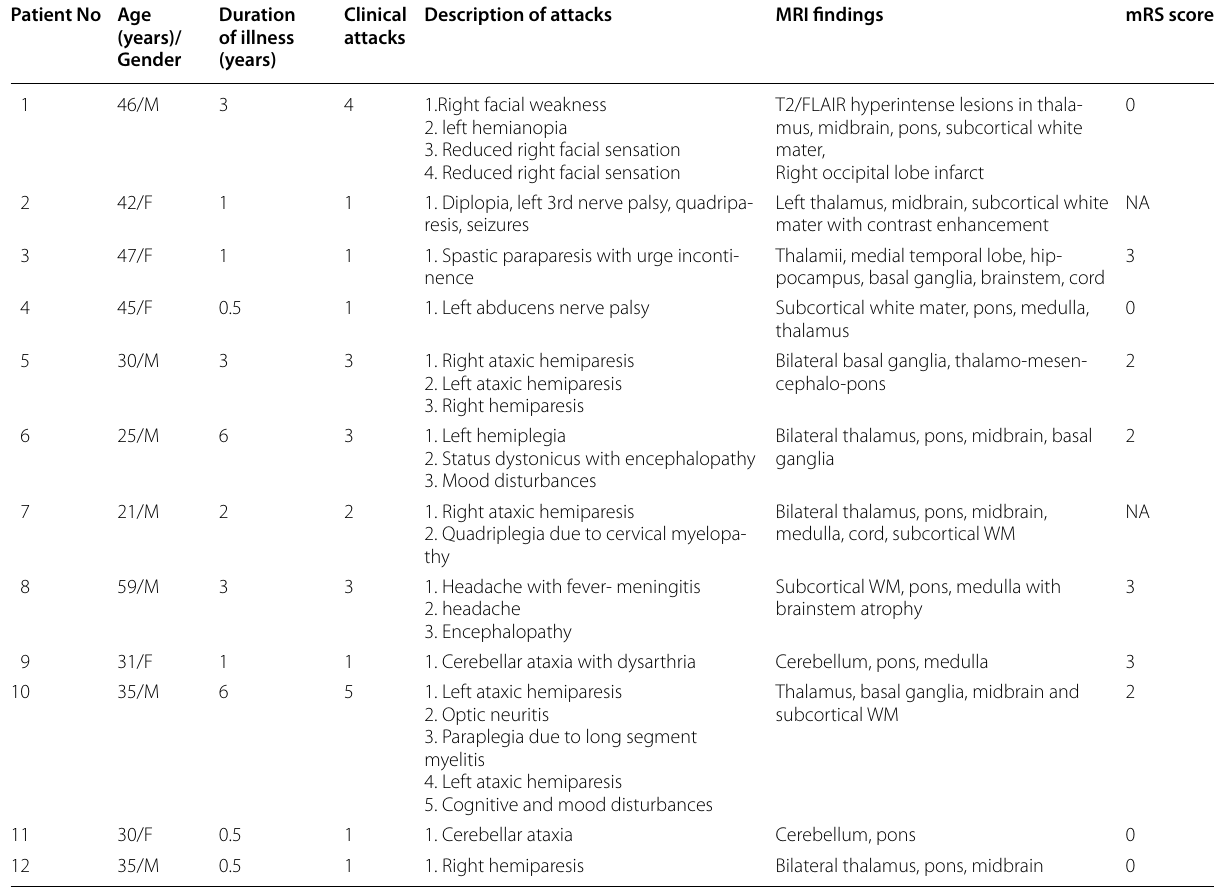
Table 1 Brief summary of clinical, radiological profile and outcome of patients Patient No Age